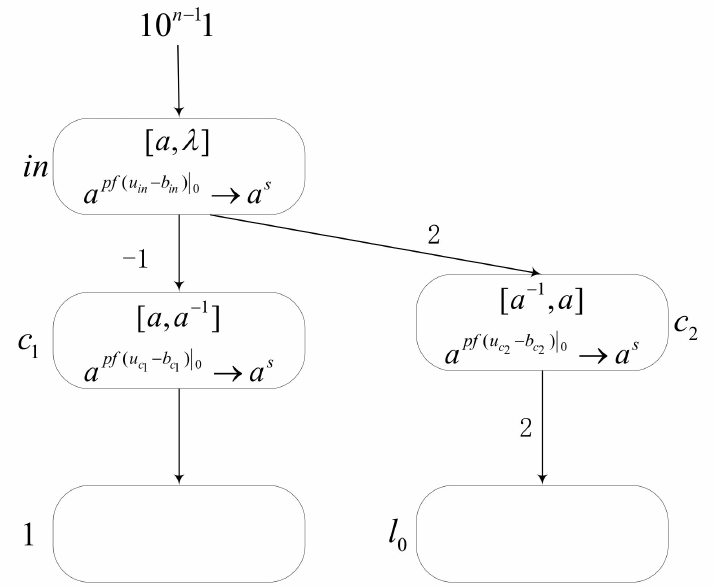
Figure 8. Module INPUT. Its function is to read the spike train to model Π